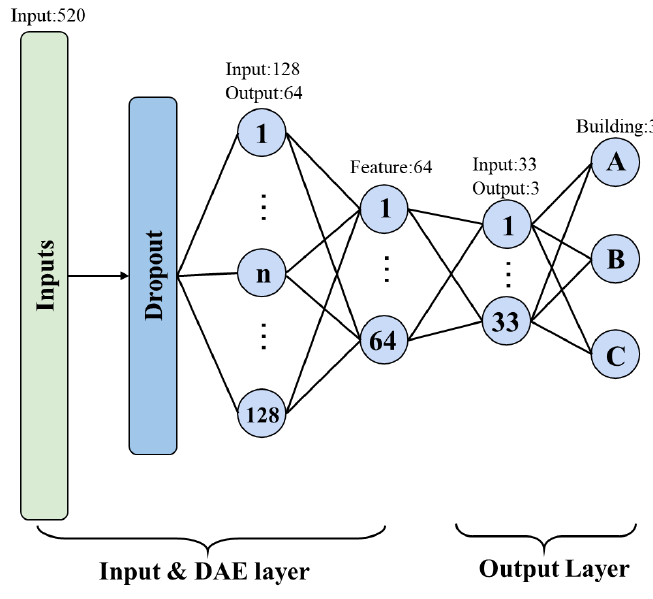
Figure 3. Multi-building positioning